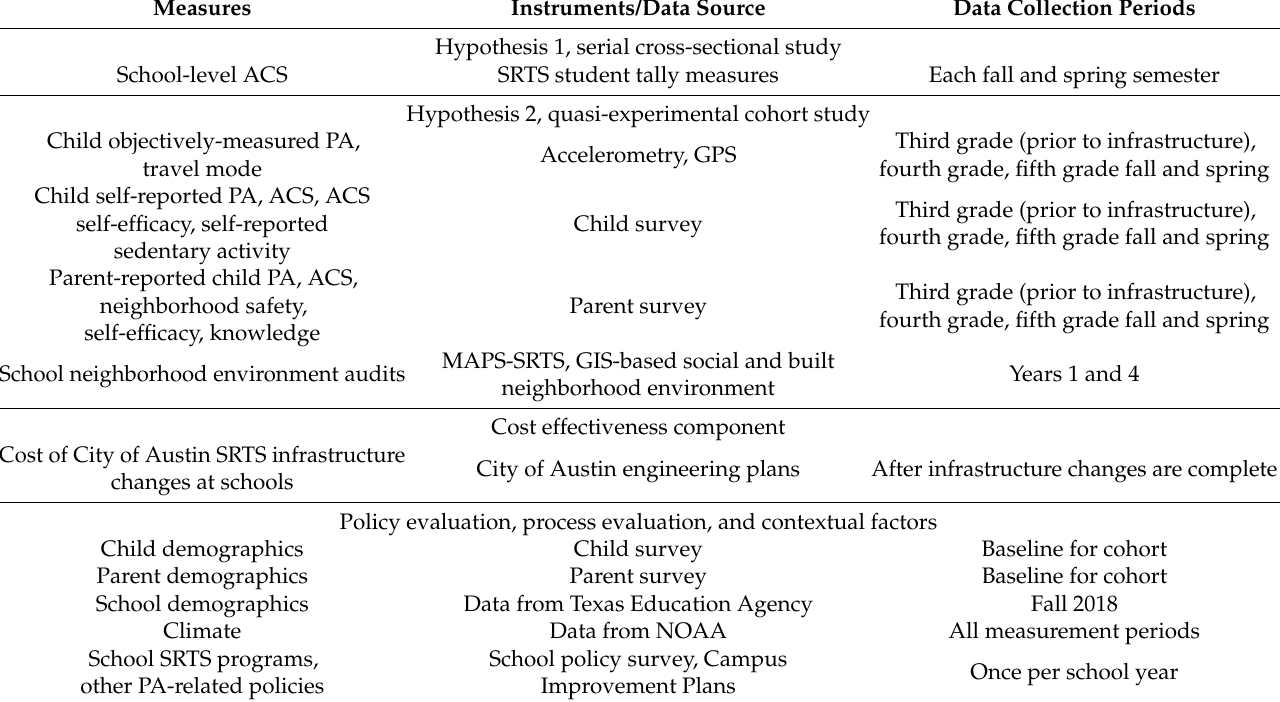
Table 1. Safe TRavel Environment Evaluation in Texas Schools (STREETS) study design, measures, and time